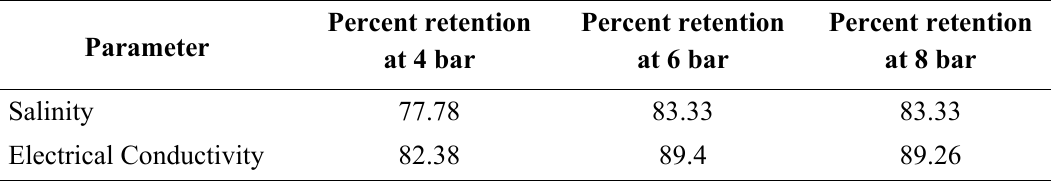
Table 9. Retention percentage (% R ) of salinity and electrical conductivity at various pressures for Sample